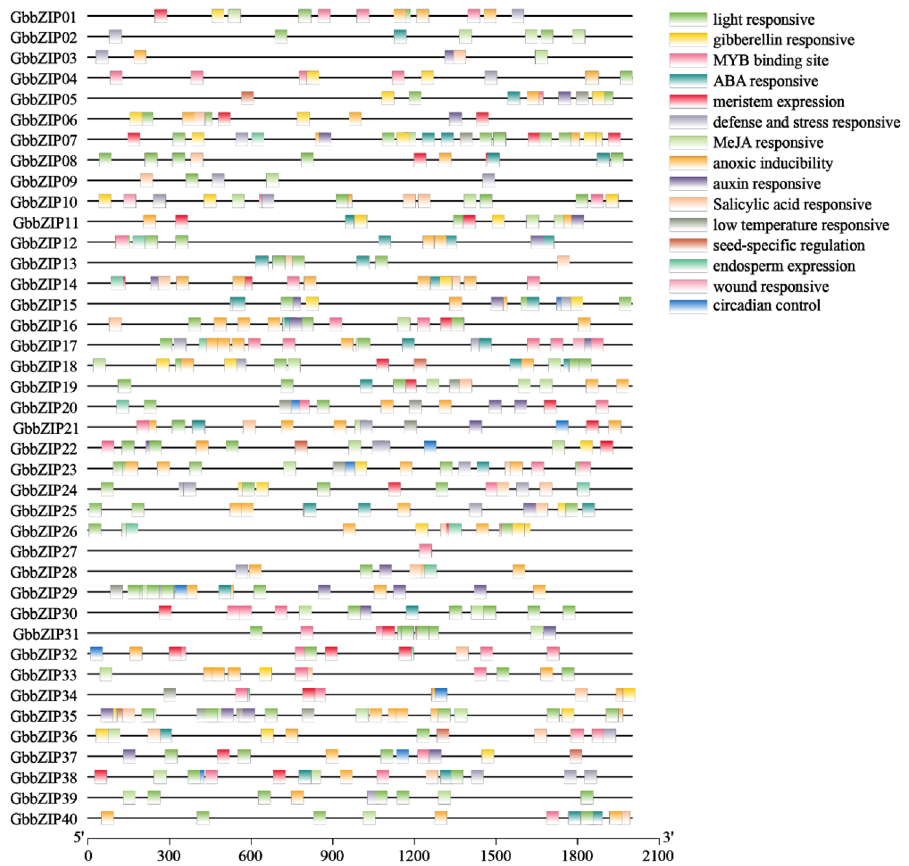
Figure 5. Cis-acting elements on the promoters of G. biloba bZIP genes. The 2000 bp upstream sequences of the transcription start site in GbbZIPs were extracted from the G. biloba genome database, and their promoter sequences were submitted to the PlantCARE website (http:// bioin forma tics. psb. ugent. be/ webto ols/ plant care/